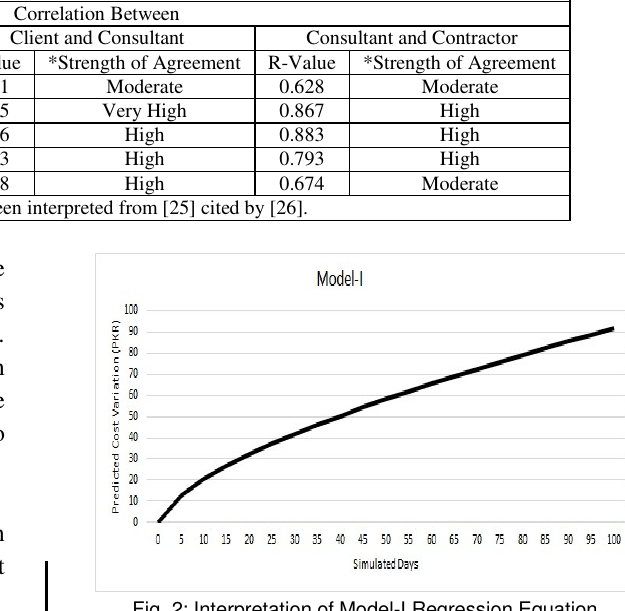
Table 9: Correlation and Qualitative Strength of Agreement between Stakeholders Correlation Between Category Contractor and Client Client and